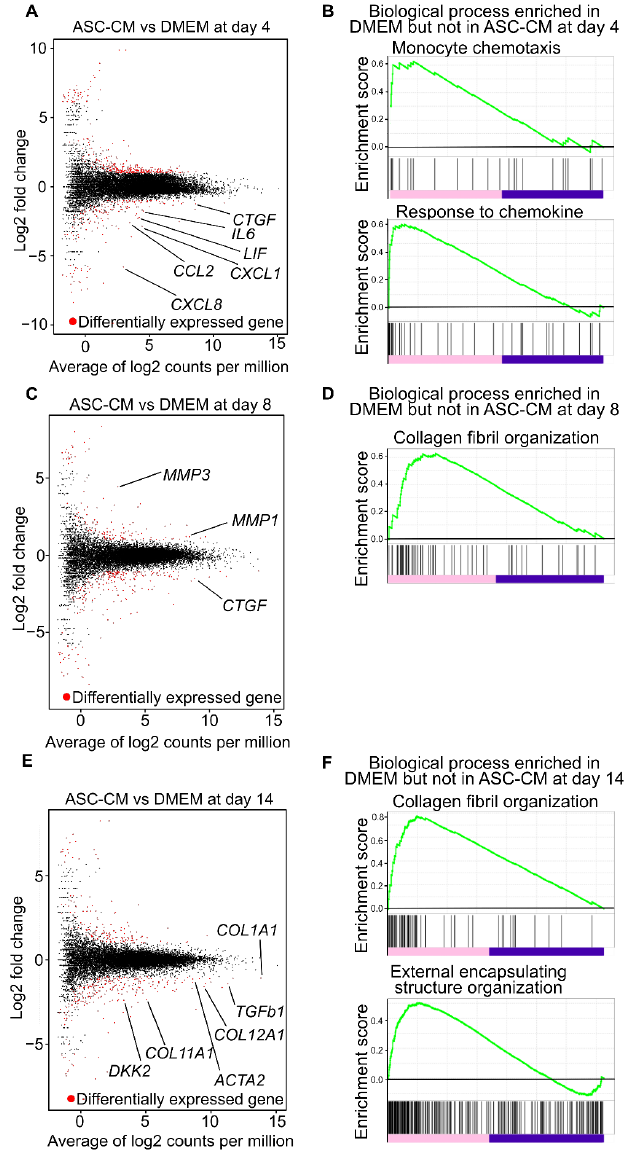
Figure 6. Global gene expression pattern in ASC-CM treatment. ( A ) MA plot, a scatter plot of log2 fold-change versus the average of log2 counts per million, showing differentially expressed genes as red points (adjusted p value < 0.05 and log2 [fold change] > 1) in ASC-CM treated KF discs compared to DMEM treated KF discs on day 4. ( B ) GSEA of DMEM treated KF discs and ASC-CM treated KF discs on day 4. Enrichment plots of expression signatures of “monocyte chemotaxis” and “response to chemokine”. ( C ) MA plot, a scatter plot of log2 fold-change versus the average of log2 counts per million, showing differentially expressed genes as red points (adjusted p value < 0.05 and log2 [fold change] > 1) in ASC-CM treated KF discs compared to DMEM treated KF discs on day 8. ( D ) GSEA of DMEM treated KF discs and ASC-CM treated KF discs on day 8. Enrichment plots of expression signatures of “collagen fibril organization”. ( E ) MA plot, a scatter plot of log2 fold-change versus the average of log2 counts per million, showing differentially expressed genes as red points (adjusted p value < 0.05 and log2 [fold change] > 1) in ASC-CM treated KF discs compared to DMEM treated KF discs on day 14. ( F ) GSEA of DMEM treated KF discs and ASC-CM treated KF discs on day 14. Enrichment plots of expression signatures of “collagen fibril organization” and “external encapsulating structure organization”. Abbreviations: ASC-CM, conditioned media derived from adipose stem cells; DMEM, Dulbecco’s modified Eagle’s medium; KF, keloid fibroblasts; GO, Gene Ontology; ECM, extracellular matrix; GSEA, Gene Set Enrichment